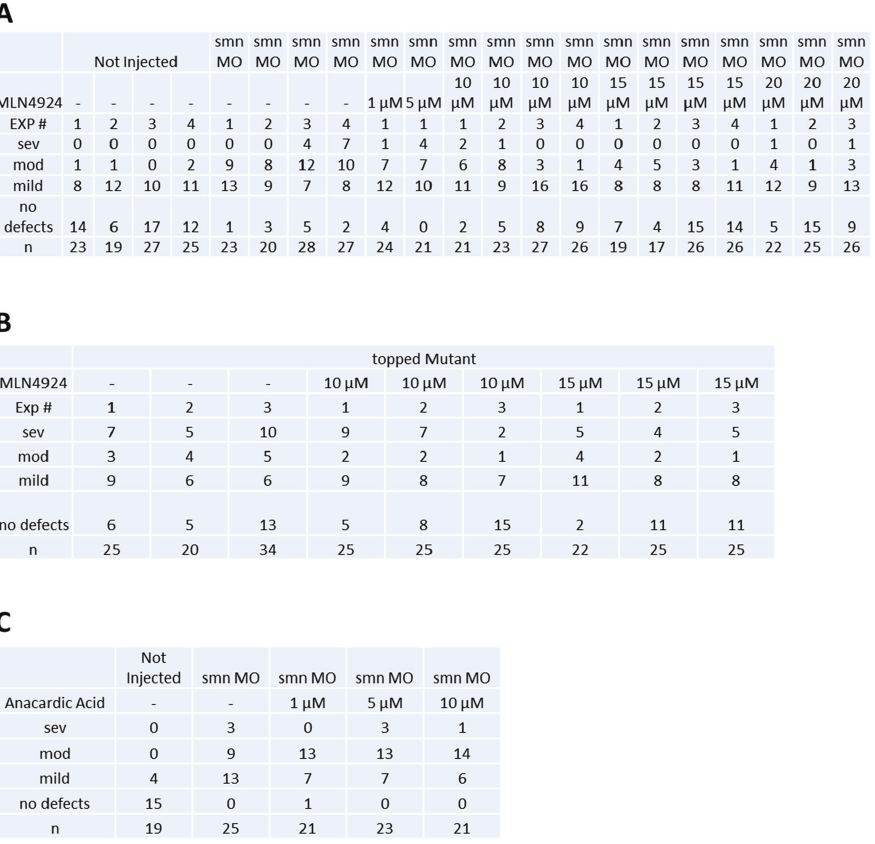
Figure S6. Zebrafish raw data. A ) MLN4924 treatment in smn MO zebrafish. B ) MLN4924 treatment in topped mutant zebrafish. C ) Anacardic acid treatment in smn MO zebrafish.